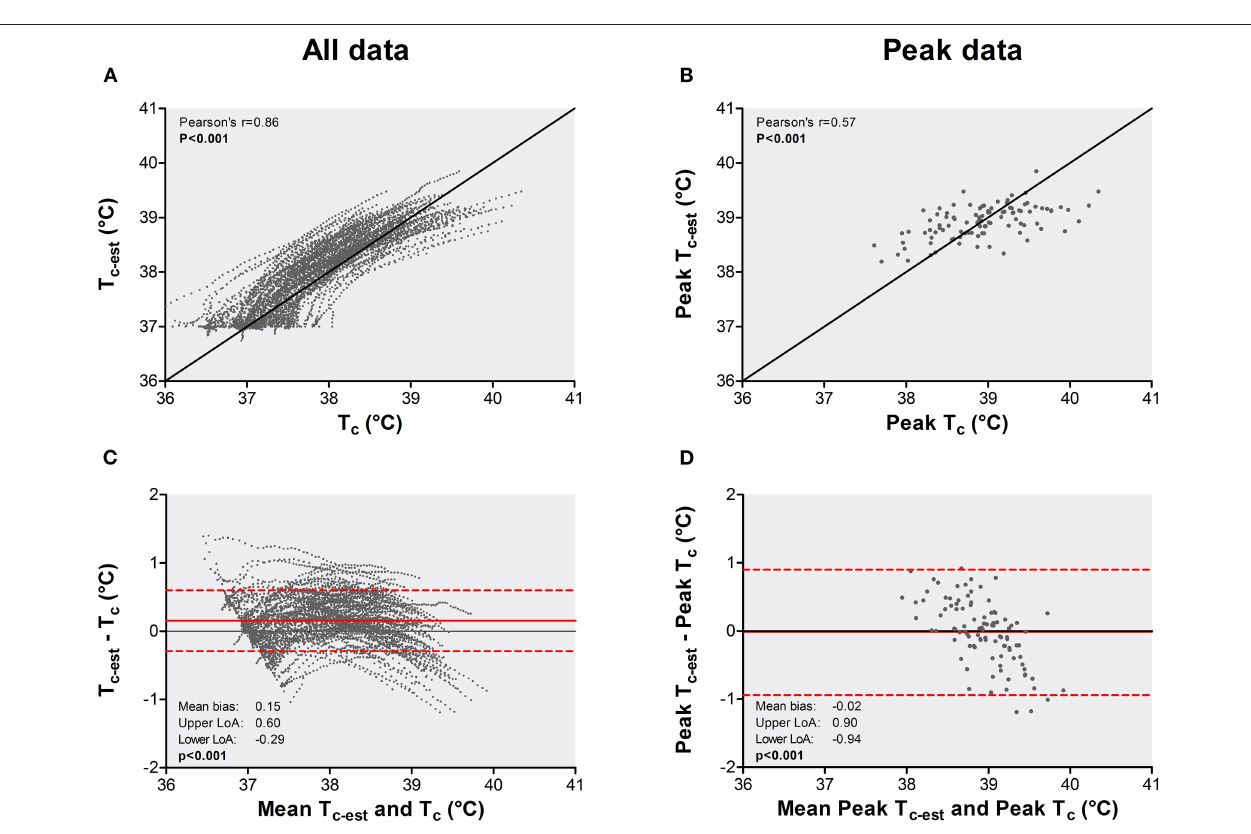
FIGURE 3 | Bi-variate correlation and Bland-Altman plots for T c − est vs. T c across all data (panel A,C ) and peak data (panel B,D ). The bivariate correlations (A,B) are plotted with the line of identity as a solid black line. Data in Bland-Altman plots (C,D) is presented as mean difference (solid red line) and the upper and lower limits of agreement (dotted red